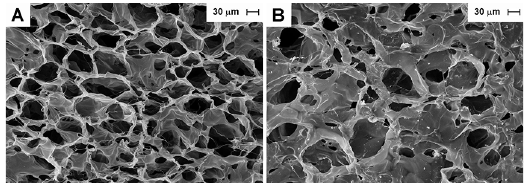
Figure 2. SEM images of (A) QN and (B) QNM. Magnification of 500 x.